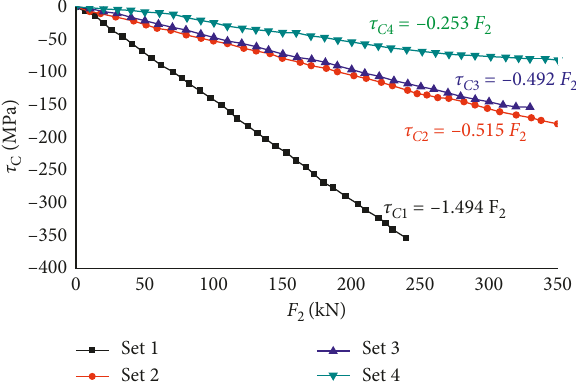
Figure 9: Shearing stresses in the bottom